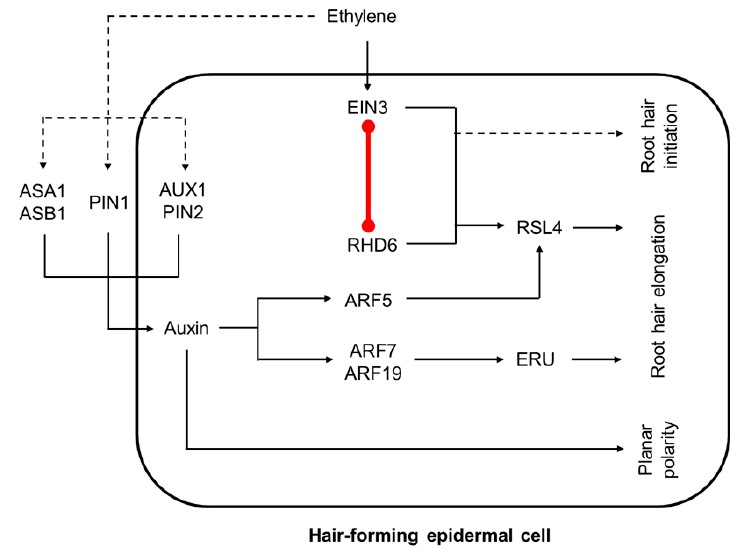
Figure 6. The model of auxin-ethylene crosstalk during root hair development. Auxin redistribution contributes to the ethylene effects on planar polarity of root hair-forming cell and root hair growth (zone ii. in Figure 3). However, ethylene acts independently of auxin redistribution as well. EIN3 directly interacts with RHD6 to regulate root hair initiation and elongation. Dashed lines mark the regulatory events with unknown mechanisms. Red line marks protein-protein interaction. This model is based on findings reported previously [59,63–65].